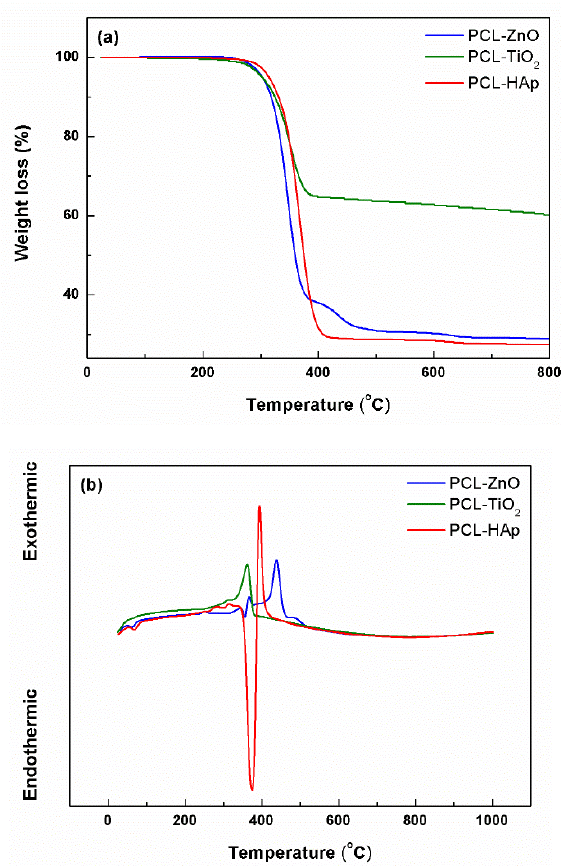
Figure 3. Thermal analyses of the composite scaffolds: ( a ) weight loss, and ( b ) differential thermal analysis.